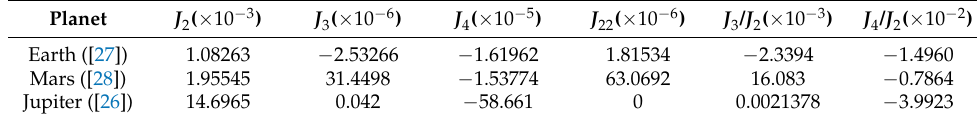
Table 1. Some harmonic coefficients and their ratios of the Earth, Mars, and Jupiter.